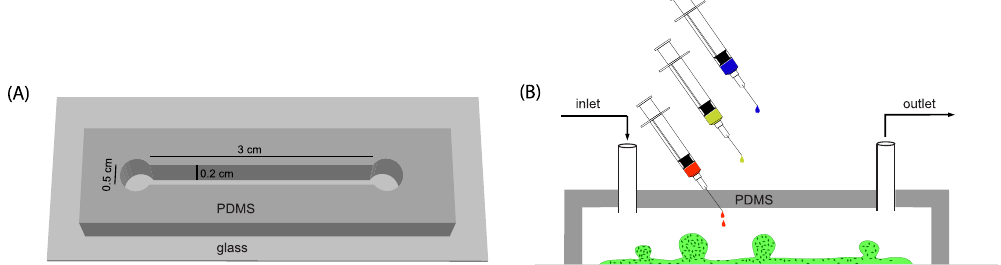
Figure 1. ( A ) Schematic of a flow cell. ( B ) Biofilms are grown in flow cells with a glass base and a PDMS top with a continuous supply of 10% Luria-Bertani broth (LB) supplied using gravity driven flow. The drug is injected into the flow cell through the PDMS while the flow is stopped. Microcolonies grow on the glass base to a size of approximately 200 μ m after a period of 2